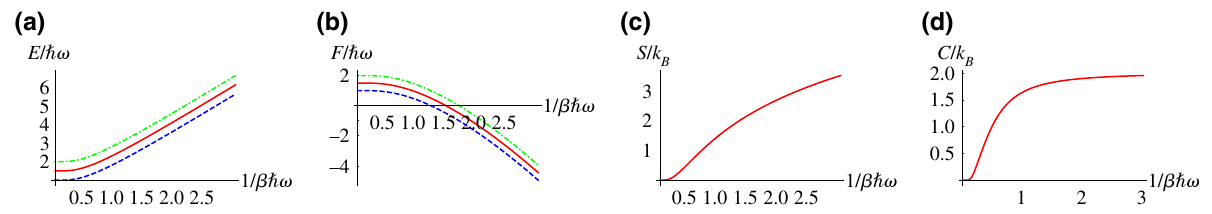
FIG. 3. Equilibrium (a) internal energy, (b) free energy, (c) entropy, and (d) heat capacity for two statistical anyons in one dimension with anyonic phase corresponding to p B = 1 (blue, dashed), p B = 1 / 2 (red, solid), and p B = 0 (green, dot